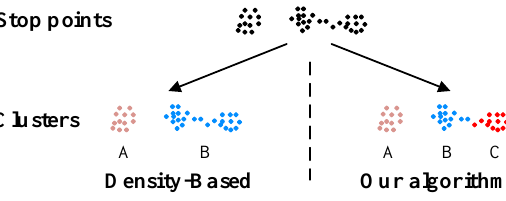
Figure 13. An example of clustering for the two algorithms.